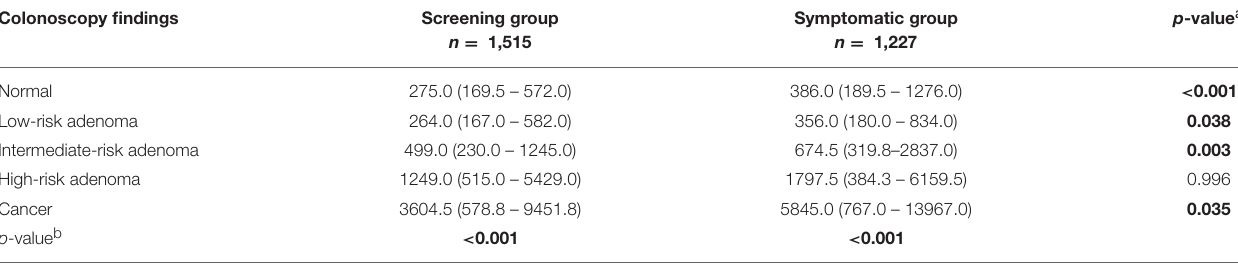
TABLE 2 | Hemoglobin FIT values according to colonoscopy findings. Colonoscopy